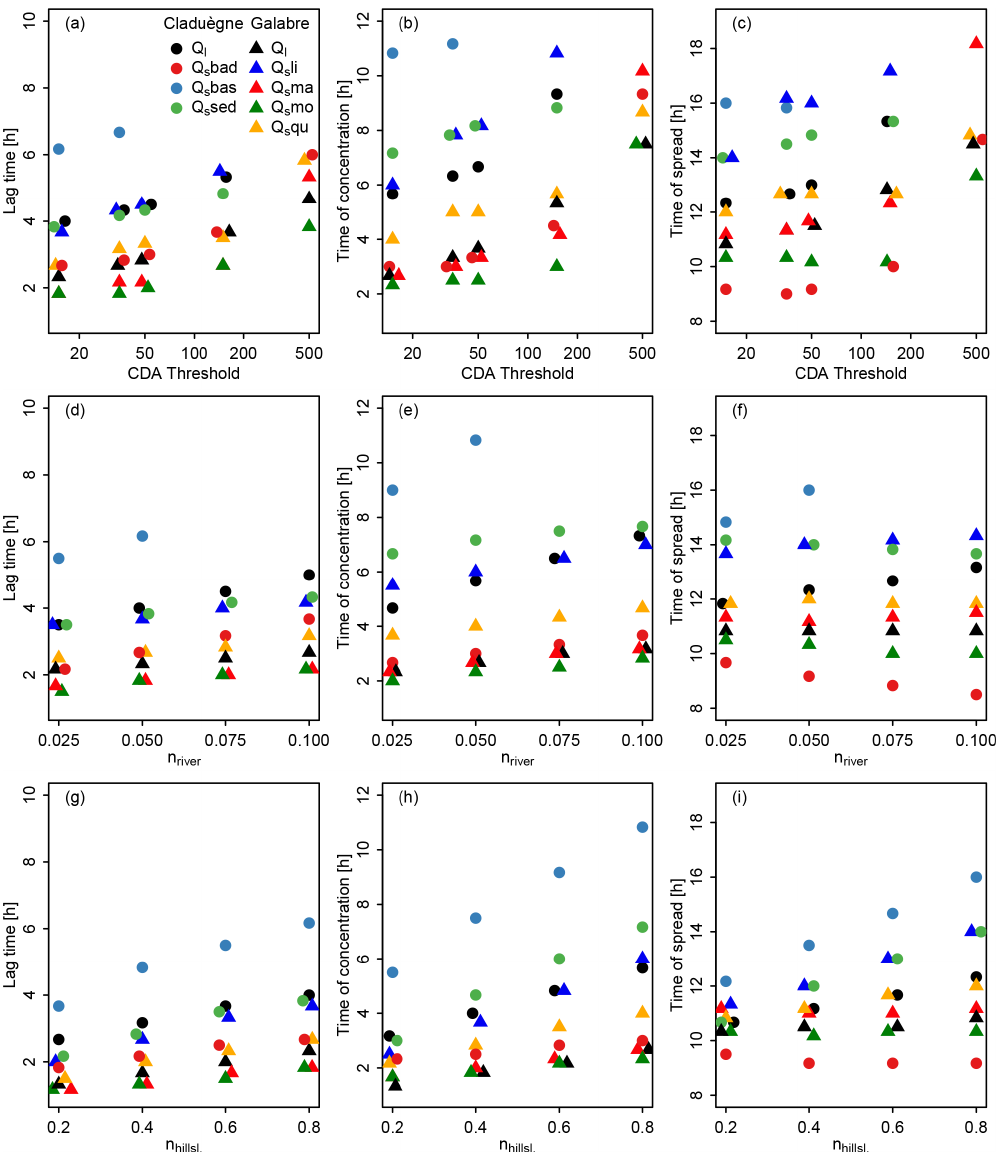
Figure 5. Sensitivity of lag times, times of concentration, and time of spread to changing the CDA threshold (a–c) , Manning’s n in the river network (d–f) and on the hillslopes (g–i) . For each catchment the characteristic times are given for liquid discharge ( Q l ) and for solid discharge ( Q s ) of the different source classes. Some symbols were slightly shifted on the x axis if they were hard to see or overlapped other